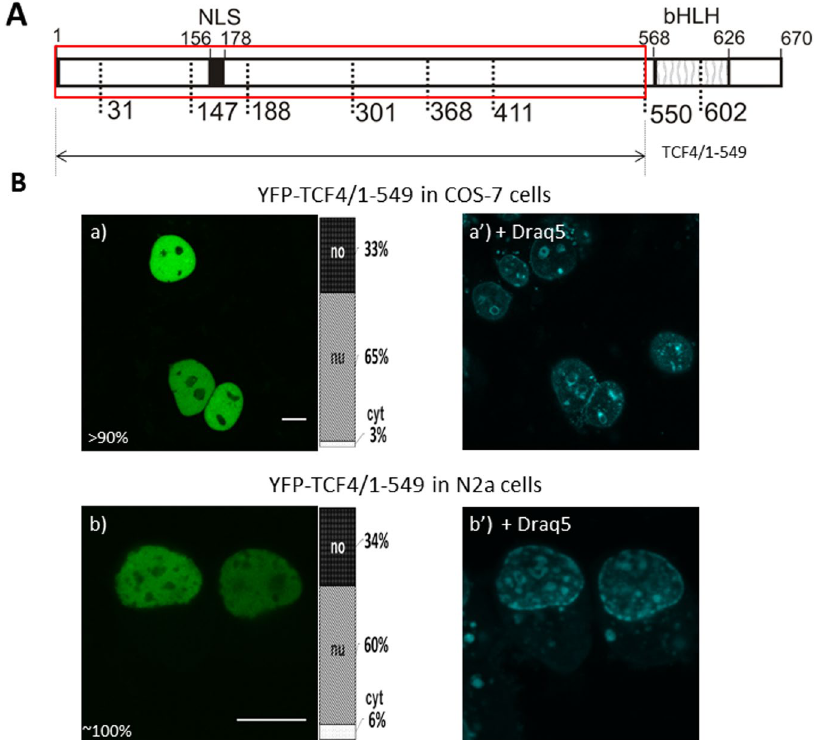
Figure 9. Subcellular distribution of TCF4 with deletion of the bHLH domain ( A ) Schematic representation of TCF4 protein. Region of the studied area of TCF4 is shown by the red rectangle. Expressed deletion mutant of TCF4 is depicted as an arrow. The length of each domain in the diagram is arbitrary. ( B ) Subcellular localizations of the expressed protein was analysed by confocal microscopy 20-24 h after transfecting COS-7 and N2a cells. Draq5 was added to the cells for DNA visualization. Representative images (single confocal plane) of subcellular distribution of the TCF4/1-549 area. Bar, 10 µ m. Ratios between mean fluorescence intensity in cytoplasmic, nuclear and nucleolar compartments are presented as an accumulated bar graph (no- nucleolus; nu- nucleus, cyt- cytoplasm). (a,a’) YFP-TCF4/188-300 expressed in COS-7 cells, (b,b’) YFP-TCF4/188-300 expressed in N2a